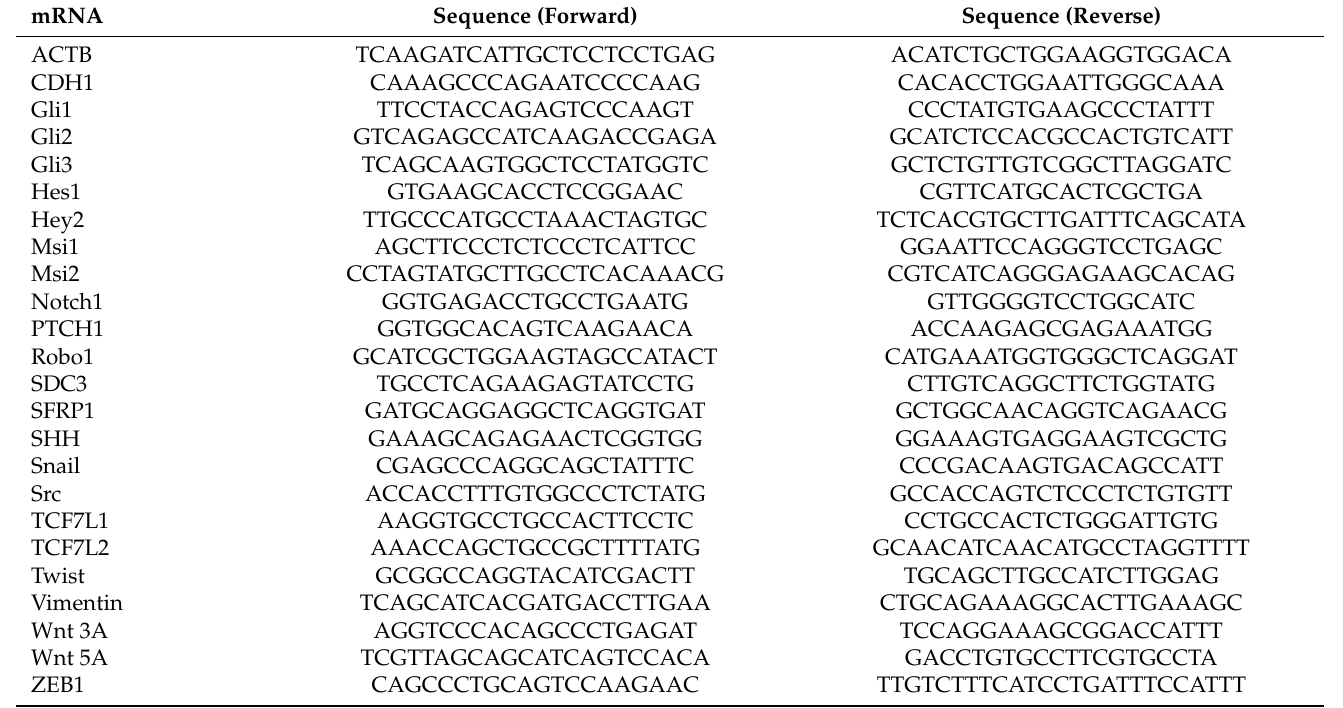
Table 2. PCR primer sequences used in this